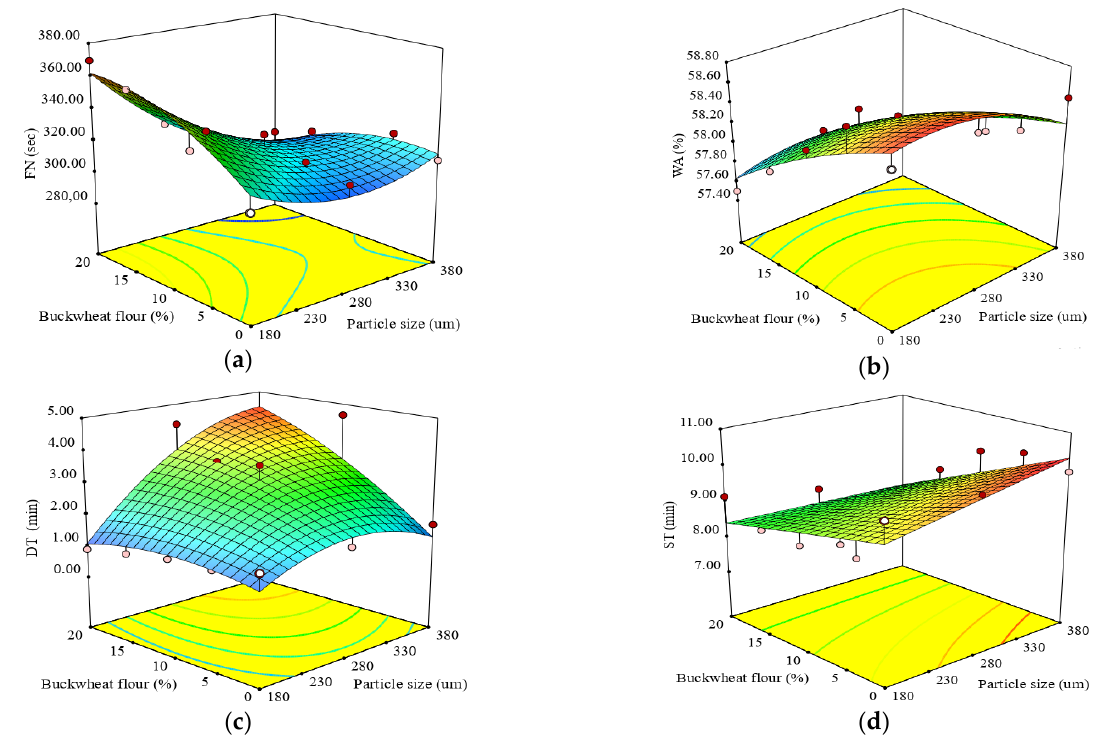
Figure 1. 3D response surface plots showing the interaction between buckwheat flour particle and addition level on ( a ) the falling number index and ( b ) water absorption (WA), ( c ) development time (DT), and ( d ) dough stability (ST) achieved during mixing.